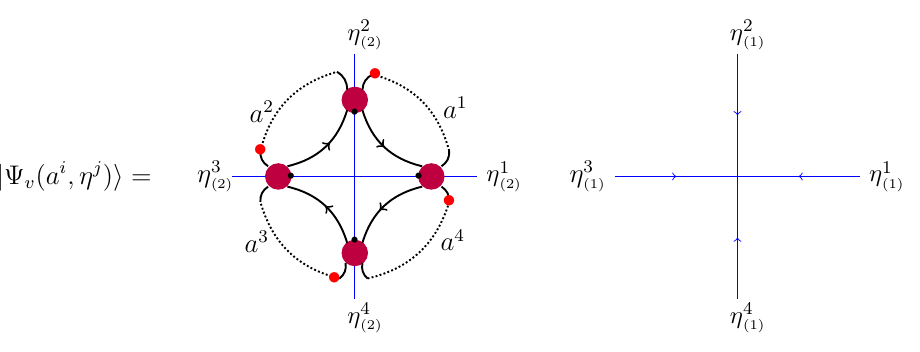
Figure 17 . Contribution associated to the vertex v to the state Ψ Γ . Note that the first diagram on the right side above is the tensor trace